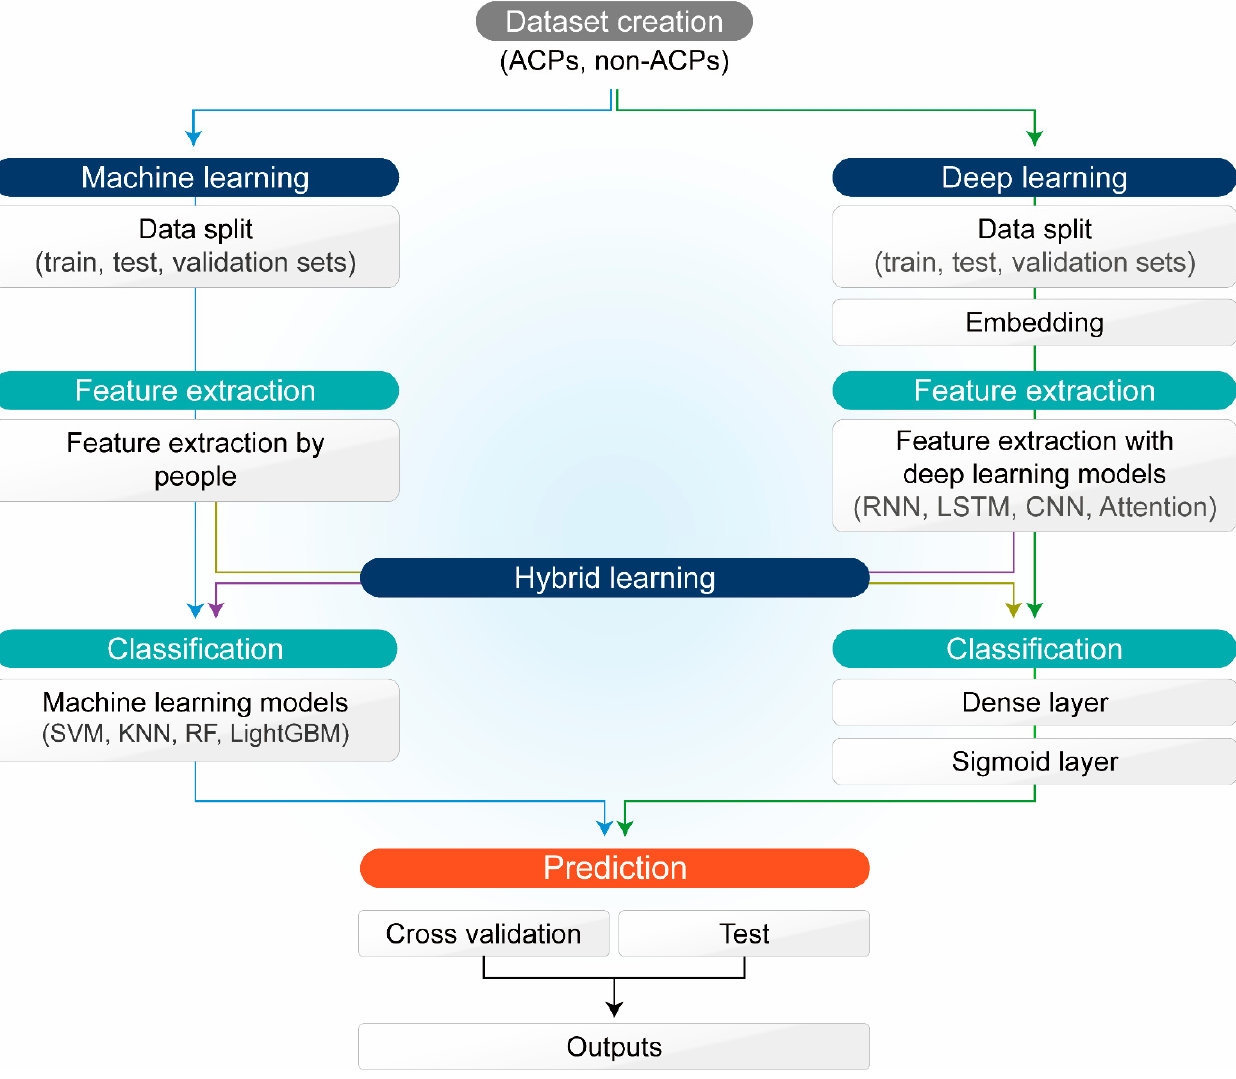
Figure 4. Schematic flowchart for development of ACPs using AI. RNN: recurrent neural network; SVM: support vector machine; K NN: k -nearest neighbor; RF: random forest; LightGBM: light gradient boosting machine.